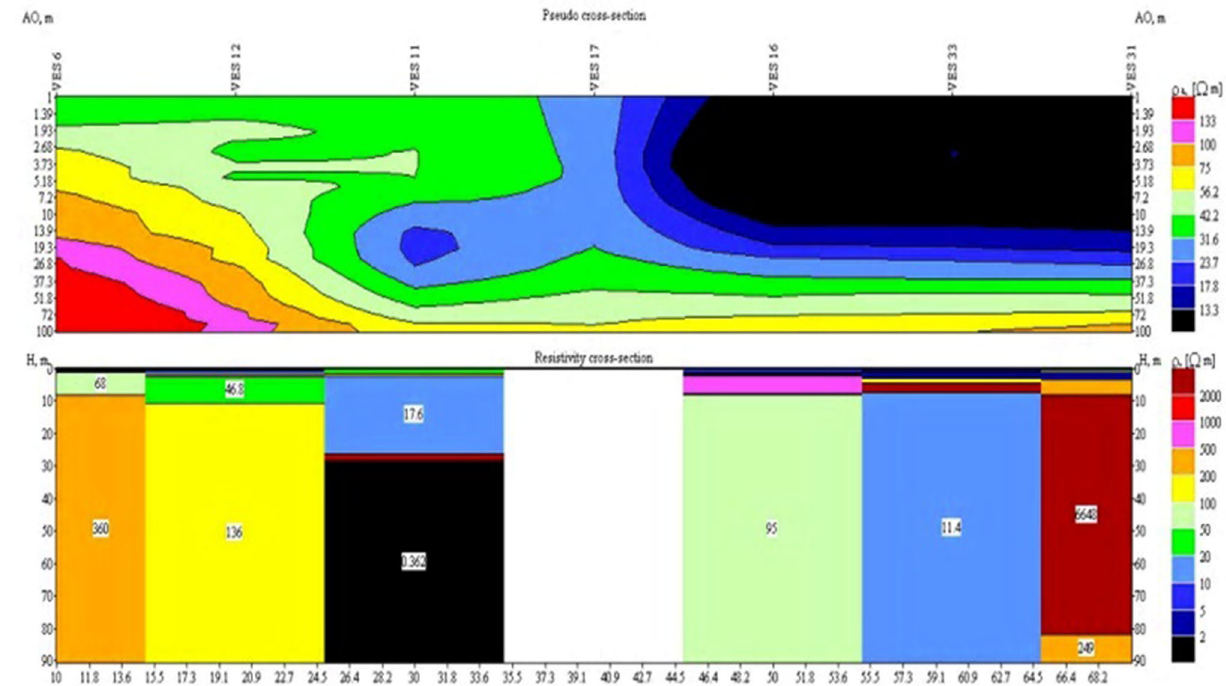
Fig. 12 Apparent and true resistivity geo-electric section along NE–SW from Dhule